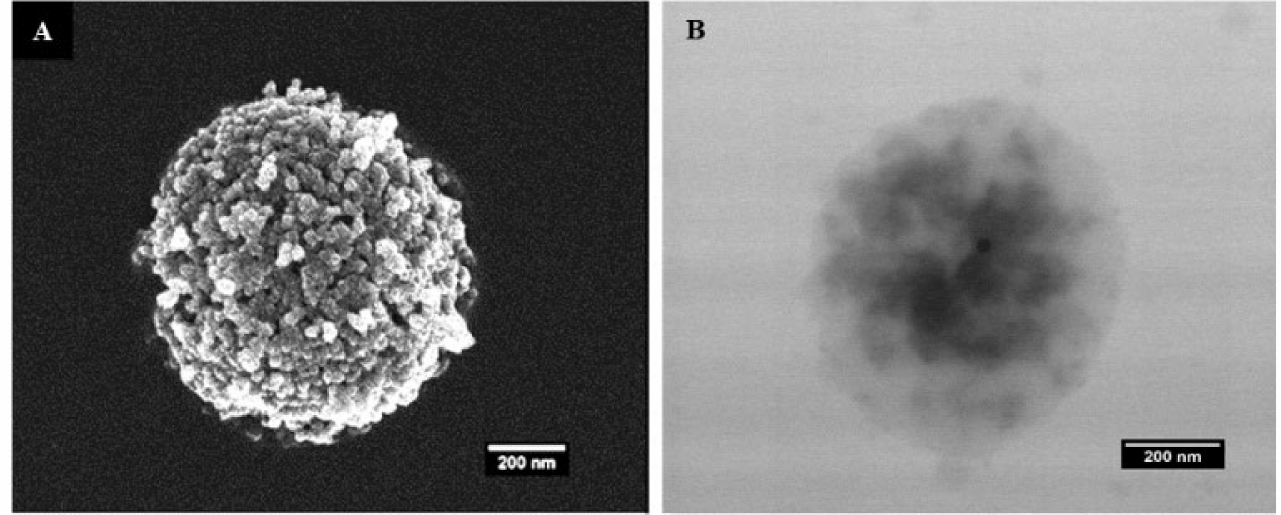
Figure 4. ( A ) field emission gun scanning electron microscopy (FEGSEM) and ( B ) transmission electron microscopy (TEM) images of MTX@COL@MIL-100